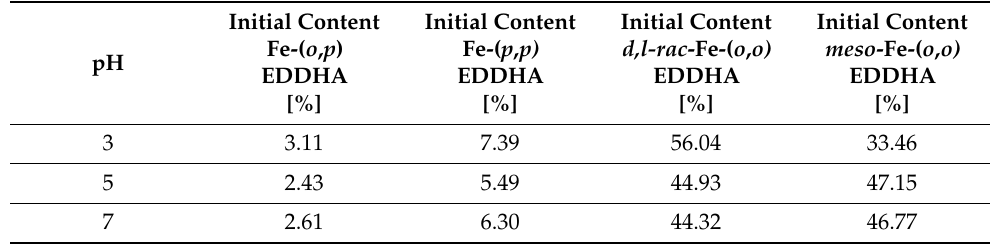
Figure 5. Iron(III) ethylenediamine- N,N ′ -di[(2-hydroxy-5-sulfophenyl)acetic acid] chelate chromatogram, which was used to study the changes in the content of chelate and iron (III) ions over time. Table 2. Content of isomers iron(III) ethylenediamine- N , N (cid:48) -bis(hydroxyphenylacetic) acid in the aqueous medium at pH 3, 5, and 7 at t =